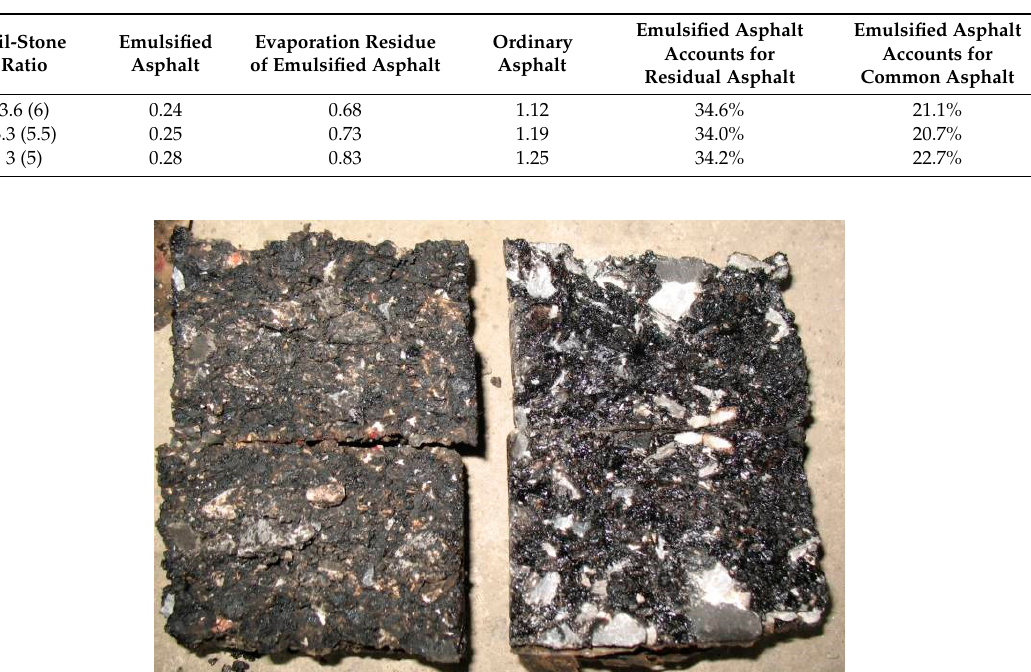
Table 10. Strength of three asphalt cement mixtures.